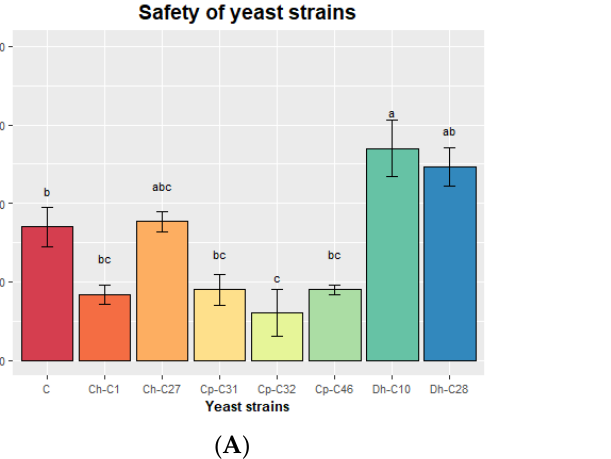
( B ) Figure 6. ( A ) Growth curves of selected yeast strains over 48 h at 28 °C and ( B ) viability of wet pellets of yeast strains stored at 4 °C at 0, 20, 50, and 65 dph (days post-harvest). Different letters indicate significant differences ( p < 0.05).